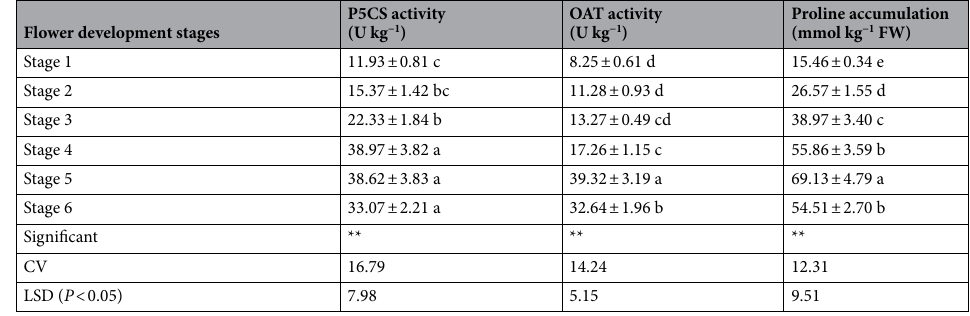
Table 3. P5CS and OAT activity accompanying by proline accumulation during rose flowers development from bud opening to petal senescence. Data shown are mean values of n = 3, and the error bars represent standard errors of the means. Mean values followed by different letters indicate they are different by LSD test at P < 0.05.